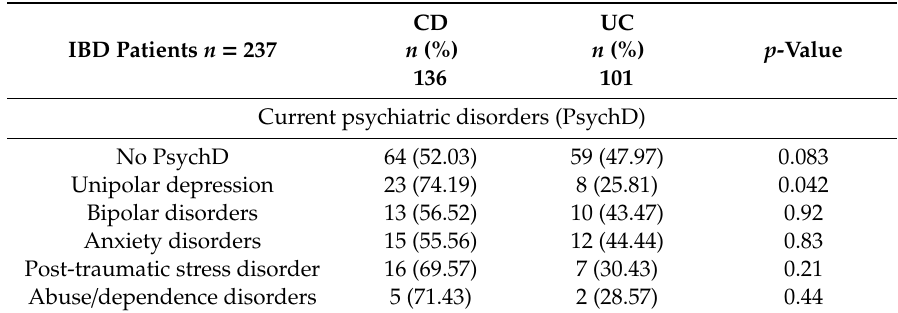
Table 4. Psychiatric diagnoses grouped into broad diagnostic categories for Crohn’s disease (CD) and ulcerative colitis